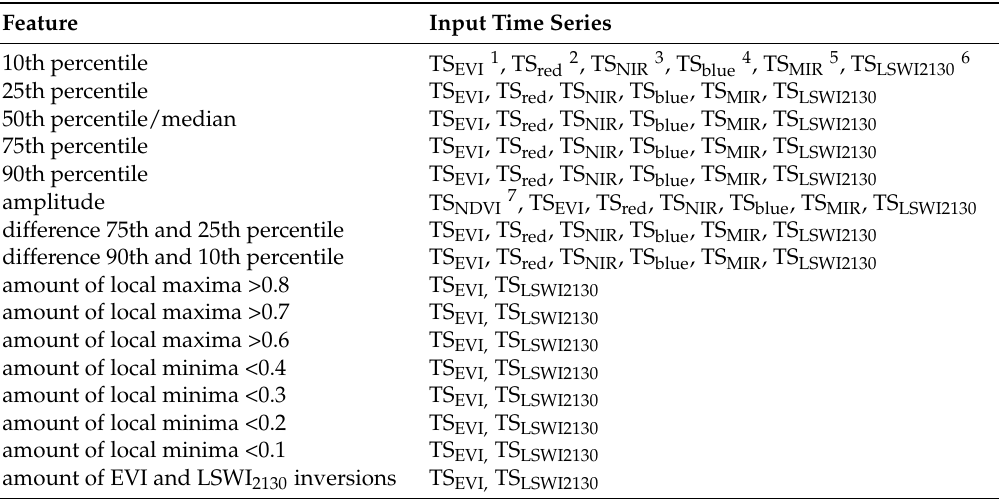
Table 1. Features extracted from the MODIS time